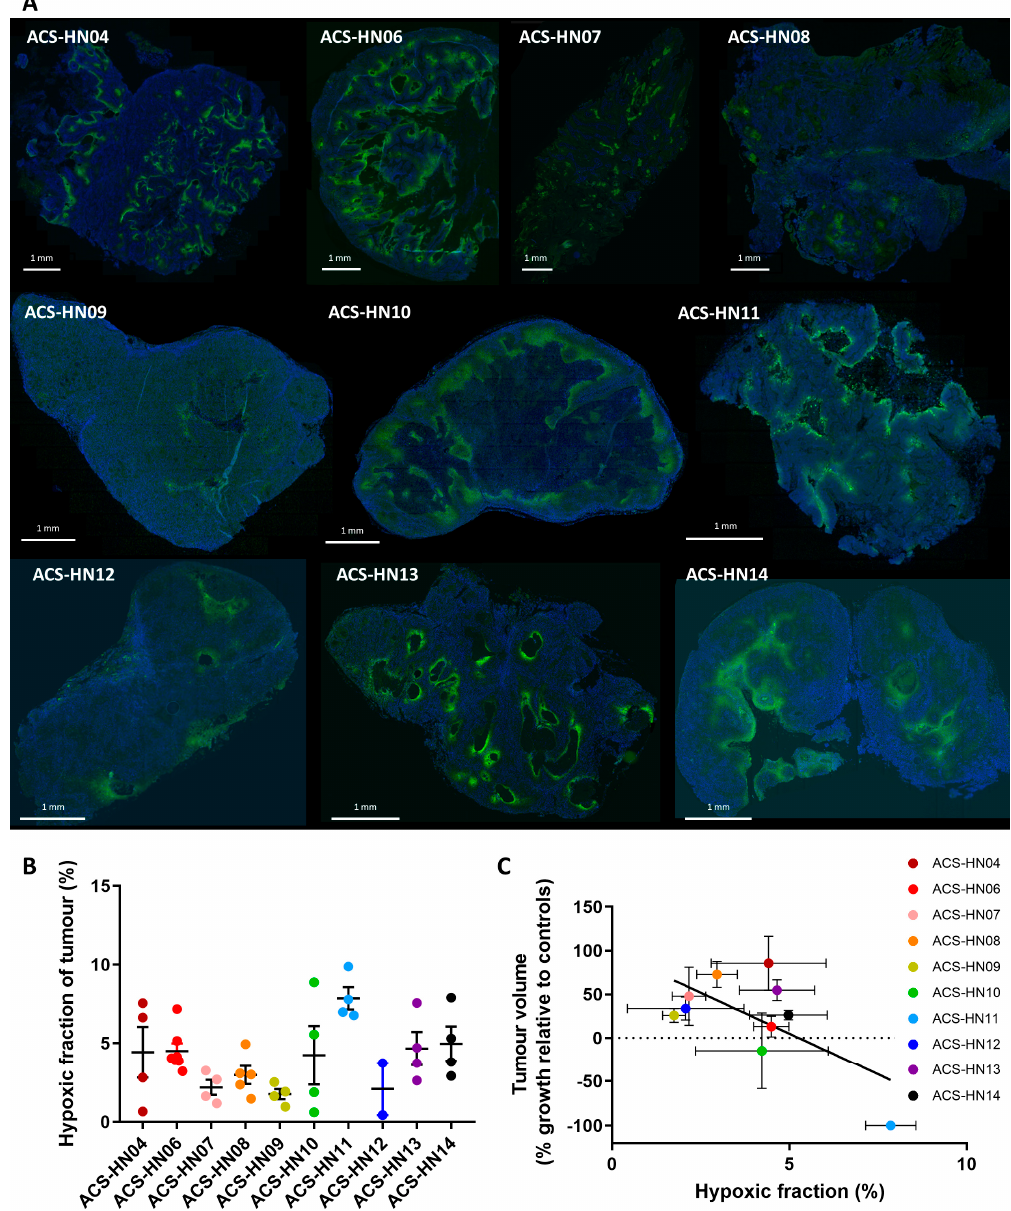
Figure 3. Hypoxic fraction of HNSCC PDX models by pimonidazole immunohistochemistry. ( A ) Representative whole tumour immunostains for each PDX model. Green, pimonidazole; blue, Hoechst 33258. ( B ) Hypoxic fraction determined as the pimonidazole-positive fraction of the viable tumour. Symbols represent individual tumours and mean ± SEM for n = 2–7 tumours. Data for ACS-HN06, ACS-HN07, and ACS-HN08 comes from [49]. ( C ) Comparison of evofosfamide antitumour efficacy (tumour growth in evofosfamide-treated mice relative to controls) to the pimonidazole-positive hypoxic fraction. Data represent mean ± SEM for n = 2–12 tumours. An orthogonal approach was used to determine the hypoxia status of the PDX tumours, by evaluating the mRNA expression of genes known to be regulated by hypoxia in HNSCC, using the Toustrup hypoxia gene signature. The mRNA expression of the 15 Toustrup hypoxia signature genes was determined by NanoString in nine PDX models, revealing differences in expression of